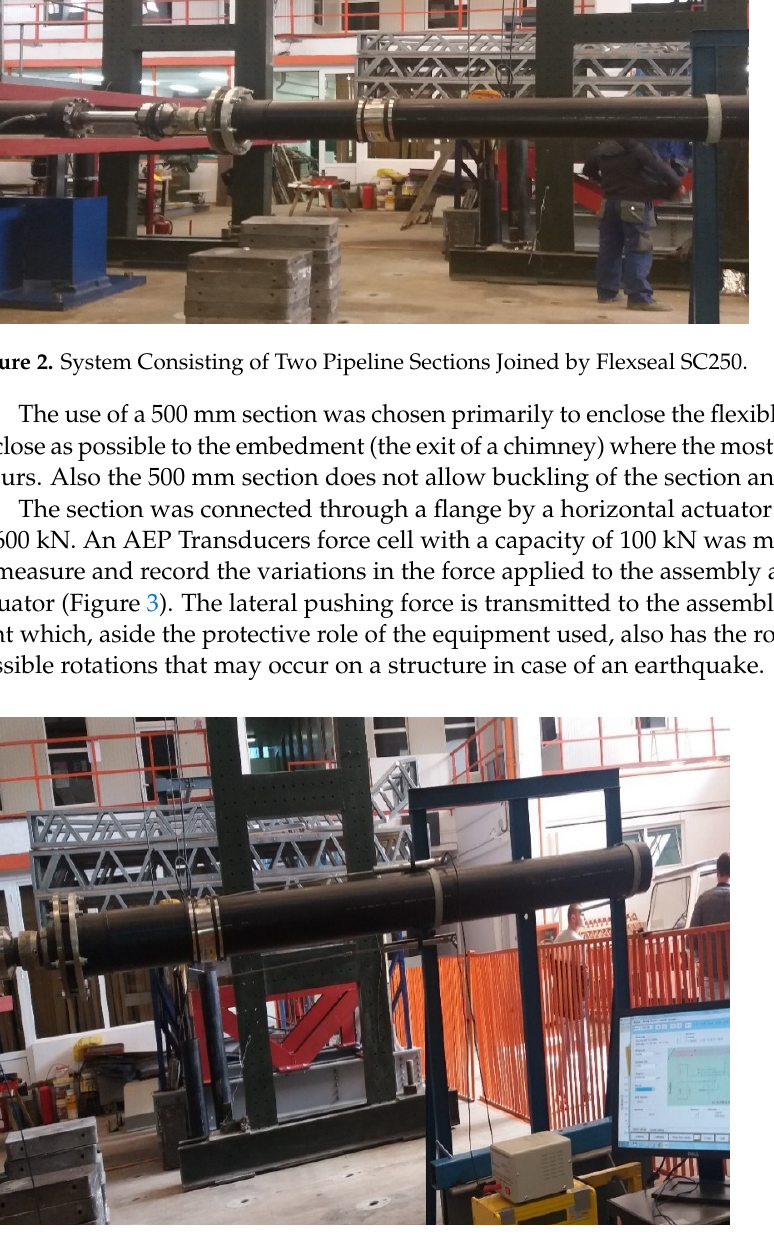
Figure 3. AEP 100 kN Force Cell and Celesco PT5AV Wire Displacement